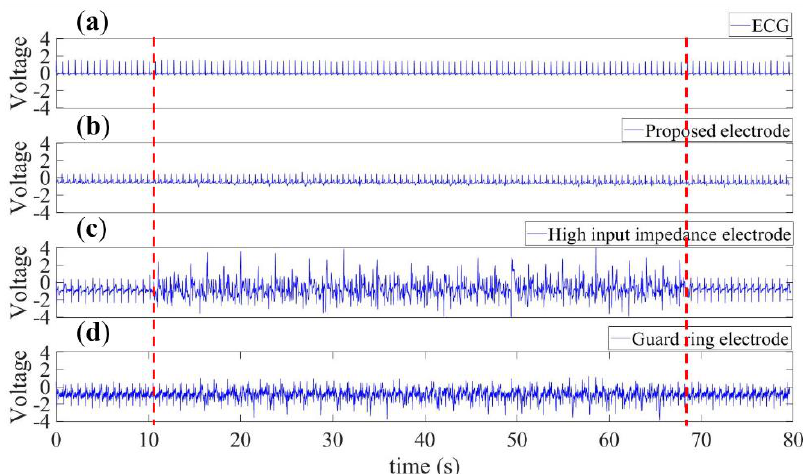
Figure 17. The ECG signal in ( a ) was measured as a benchmark, and the CECG signals in ( b – d ) were for comparison purposes using the electrodes in Figure 3a–c, respectively. There is a 99.8% correlation between RRIs extracted from the red framed signals in ( a ) and ( b ), 52% between ( a ) and ( c ), and 63% between ( a ) and ( d ).